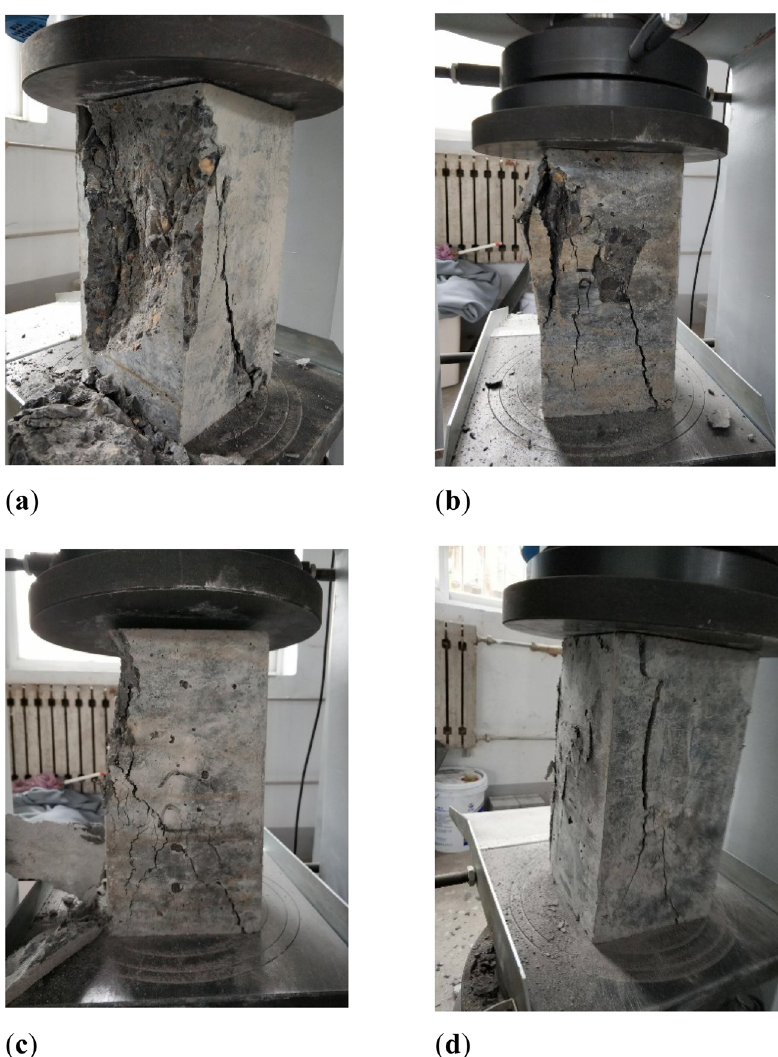
Figure 10: Prism compression failure patterns of specimens: ( a ) without PVA fi ber, ( b ) 0.2% PVA fi ber content, ( c ) 0.4% PVA fi ber content, and ( d ) 1.0% PVA fi ber